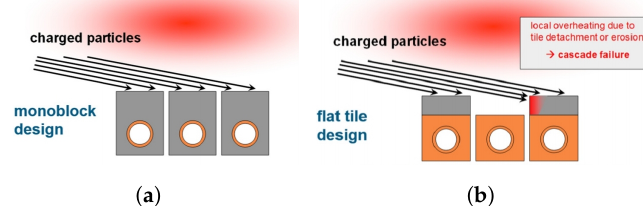
Figure 4. Main PFC designs for ITER. The charged particles depositing their energy are guided by the magnetic field lines. ( a ) Monoblock design. ( b ) Flat tile design. Reprinted from Ref. [12].